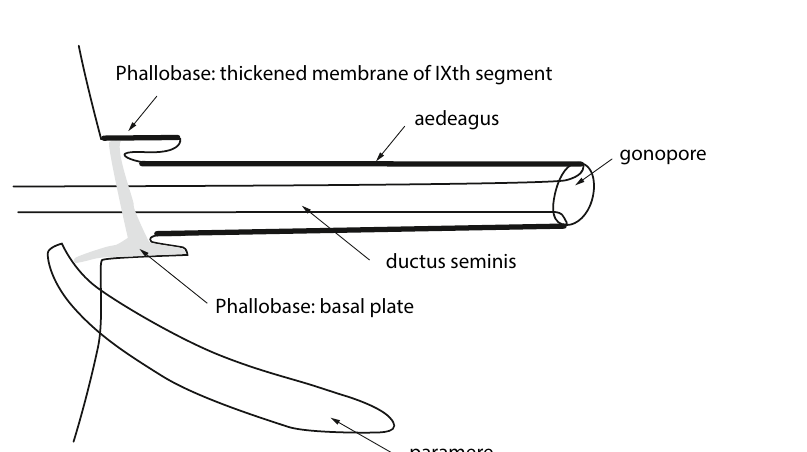
Figure 1. Schematic representation for the morphology of male terminalia. ( A ) Lateral view of a male terminalia. ( B ) Antero-posterior view of the parameres, basal plates and aedeagus. ( C ) Internal view of the right side of the Terminalia, showing the subgenital plate, the sterno-lateral plate and the intermediate plate in between. ( D ) Lateral view of the Aedeagus and